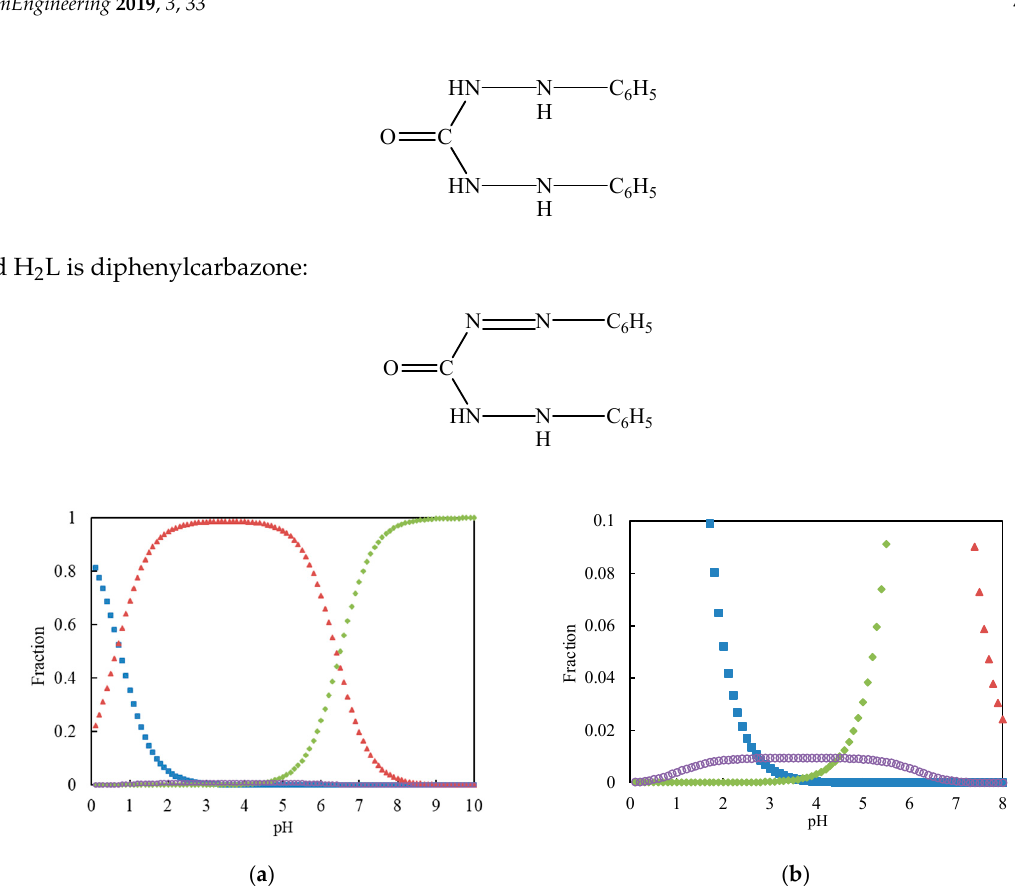
Figure 1. ( a ) Distribution of Cr(VI) species as functions of pH. Square (blue): H 2 CrO 4 ; triangle (red): HCrO 4 − ; diamond (green): CrO 42 − ; circle (purple): Cr 2 O 72 − ; ( b ) Magnification for Cr 2 O 72 − species.